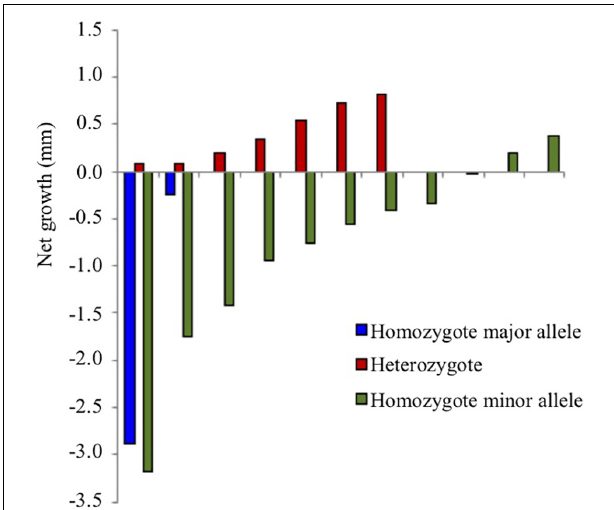
FIGURE 5 | Growth reduction (growth in future salinity minus growth in current salinity) over 45 days in population S3 in individuals of different genotype for the SNP marker annotated to calcium-binding protein 1. Positive values indicate increased growth under 4 psu decreased salinity and negative values indicate decreased growth. Individuals of the same genotype are ordered along the x -axis according to net growth (for statistic evaluation see Supplementary Table S8